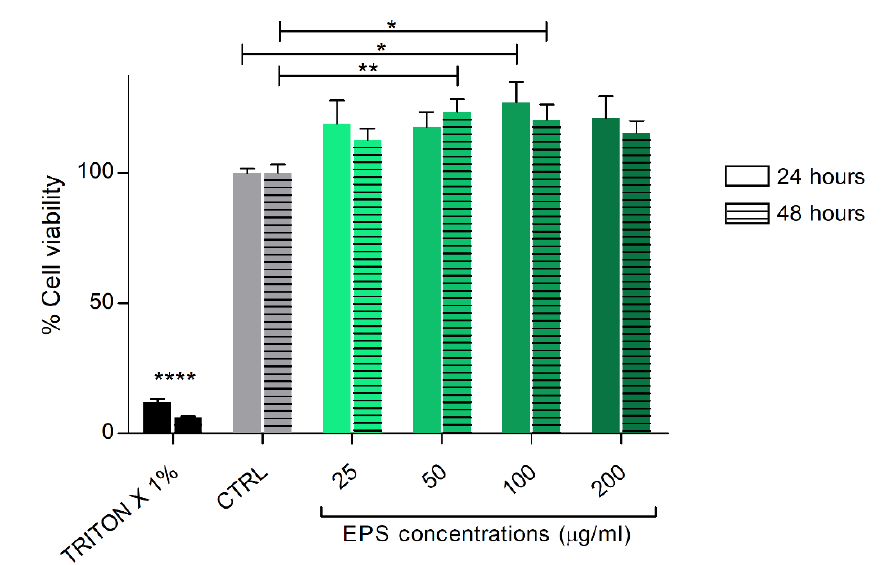
Figure 2. Cell viability analysis after HSF cells treatment with EPS from Phormidium sp. ETS05. The cells were cultured with the indicated concentrations of EPS for 24 and 48 h. Cell viability was assessed. Data are shown as the mean ± SEM of three independent experiments, each carried out in triplicate. Statistical analysis was performed using GraphPad Prism 7 (one-way ANOVA, Tukey’s multiple comparison test). Statistical significance: * p ≤ 0.05, ** p ≤ 0.01, **** p <